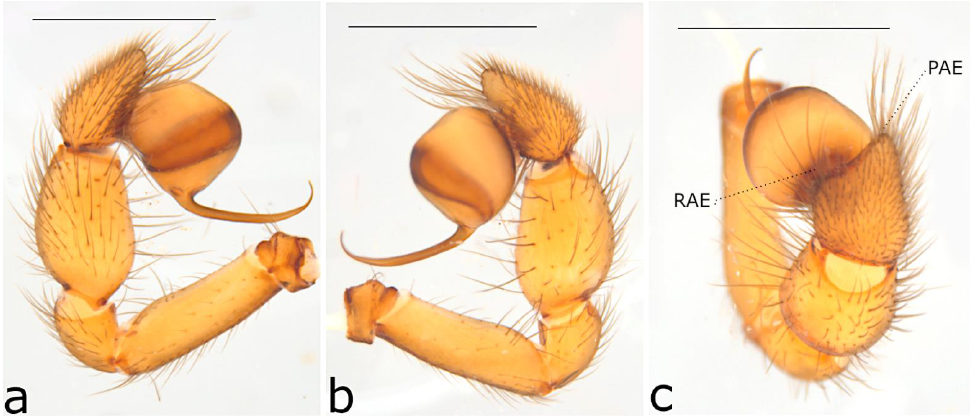
Figure 14. Ariadna sinuosa sp. nov. ♂ holotype (MV K-4989) from Mount Donna Buang (Vic): ( a ) left pedipalp, prolateral view; ( b ) same, retrolateral view; ( c ) same, cymbium. Scale bar = 1 mm. Description. ♀ (based on paratype; MV K-4990). Total length 9.0 Cephalothorax: 3.7 long, 2.3 wide, 2.7 high. Carapace golden-brown, with sparse setae, small number of elongate setae projecting from between eye groups. Chelicerae orange- brown with few sparse and scattered setae. Sternum golden-brown, with darker inter- coxal regions and paler medially. (Figure 15a – c). Carapace elongated oval, the lateral mar- gins slightly undulating; narrowing anteriorly into a broad, squared neck; fovea is a shal-